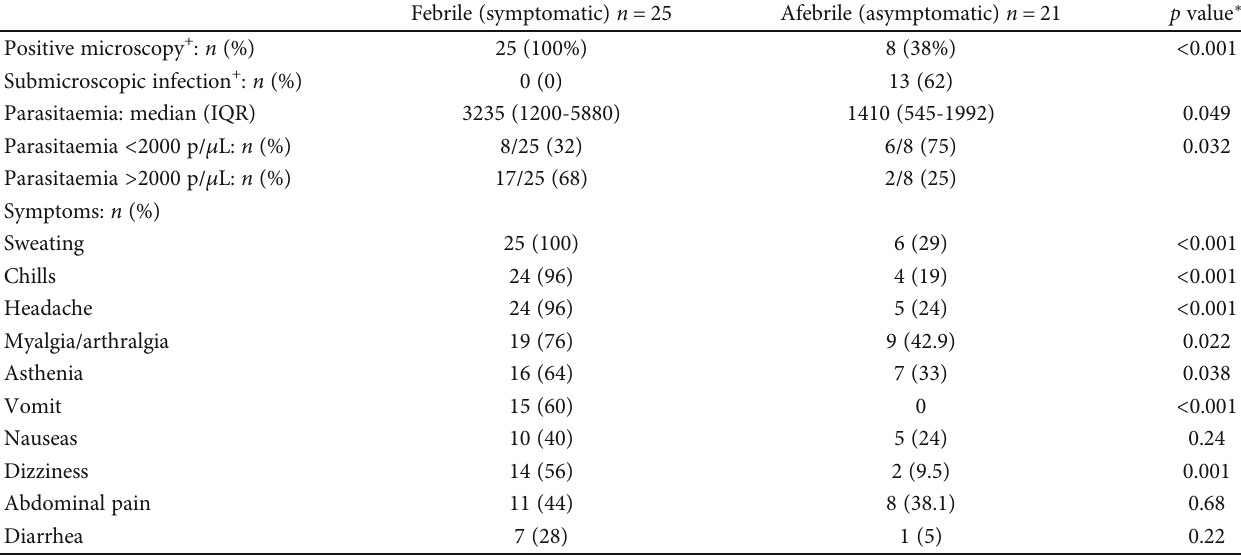
Table 6: Description of afebrile infections among infected pregnant women. Febrile (symptomatic) n = 25 Afebrile (asymptomatic) n =